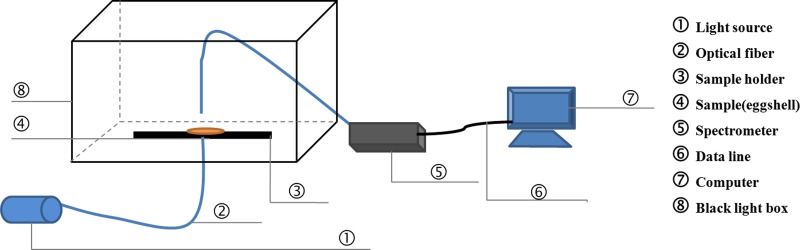
The schematic of the detection equipment for light transmission.